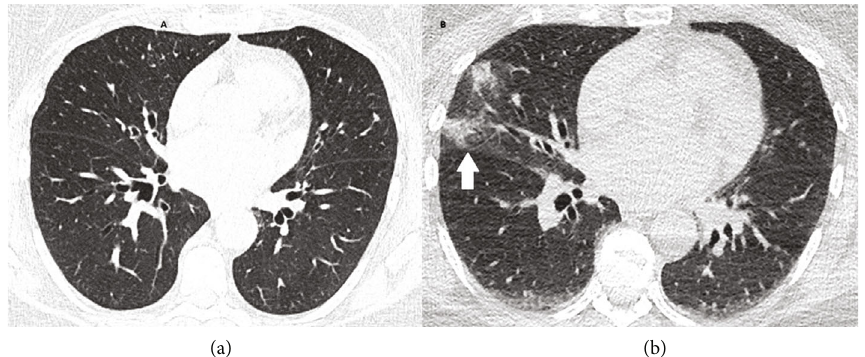
Figure 3: (a) CT thorax scan (December 2019) showed inconspicuous lung emphysema in comparison with the preoperative (b) CT scan (March 2020) with typical ground glass opacities (arrow) in the medial